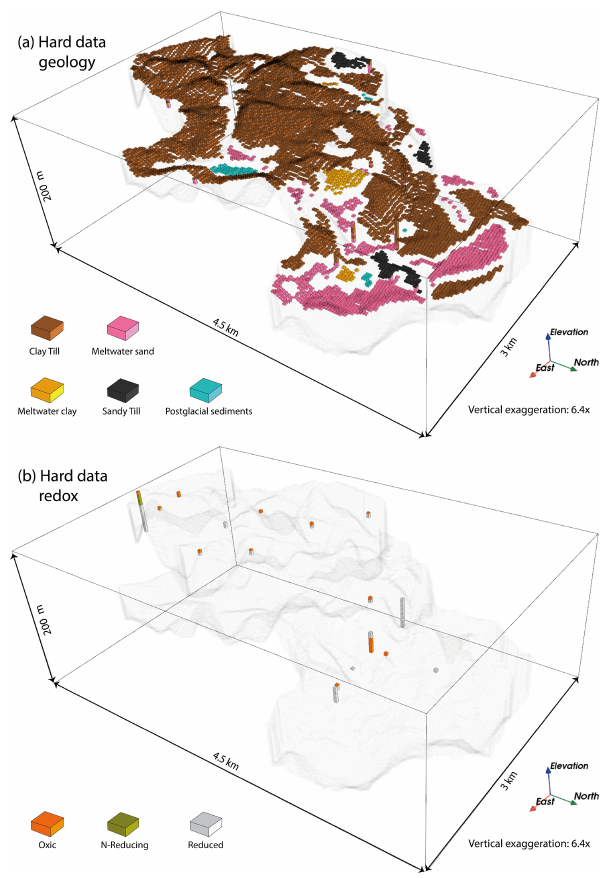
Figure 6. (a) The geology surface map along with the geology wells placed on the simulation grid as hard data. (b) The redox wells on the simulation grid as hard